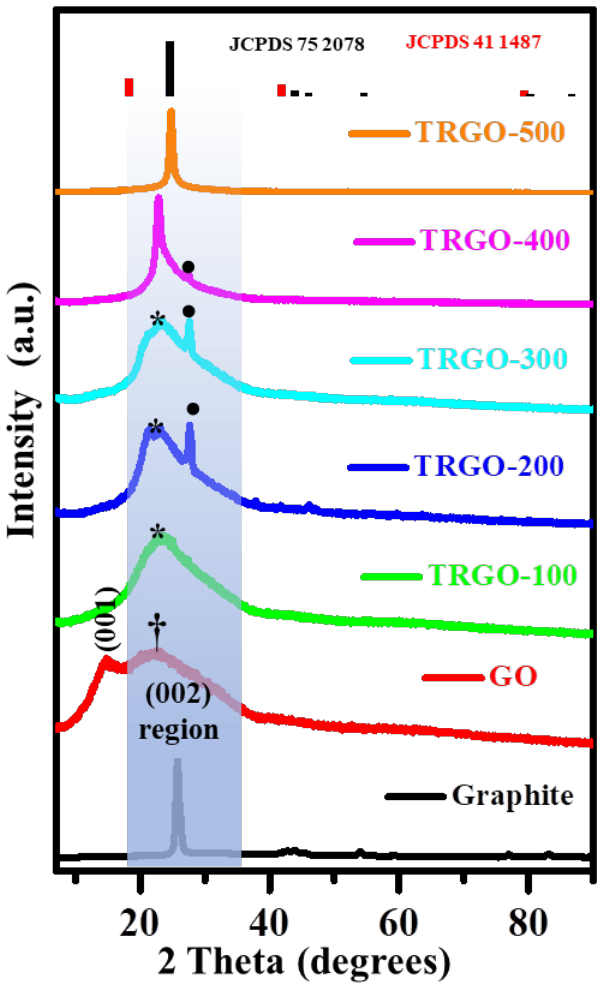
Figure 2. The XRD spectra for graphite, GO, and TRGO-100 to TRGO-500.